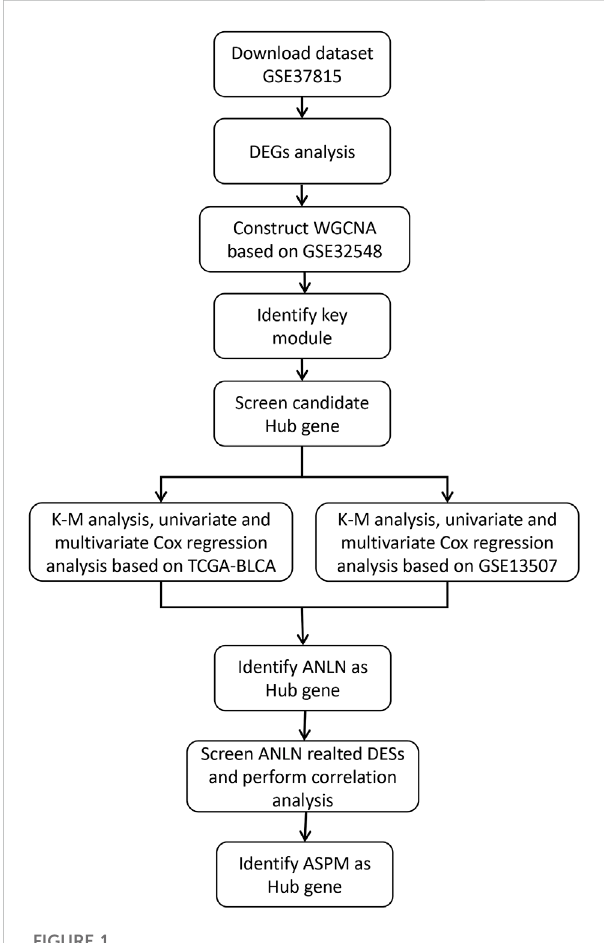
FIGURE 1 Work fl ow chart of screening bladder cancer biomarkers based on WGCNA.